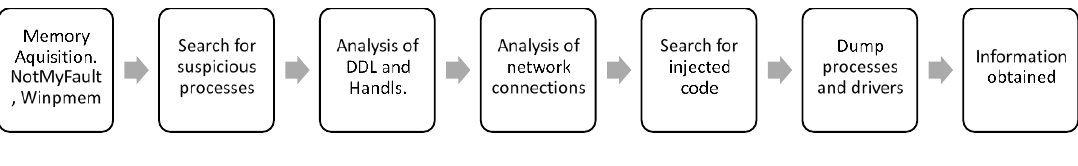
Figure 9. Memory Figure 9. Memory analysis.